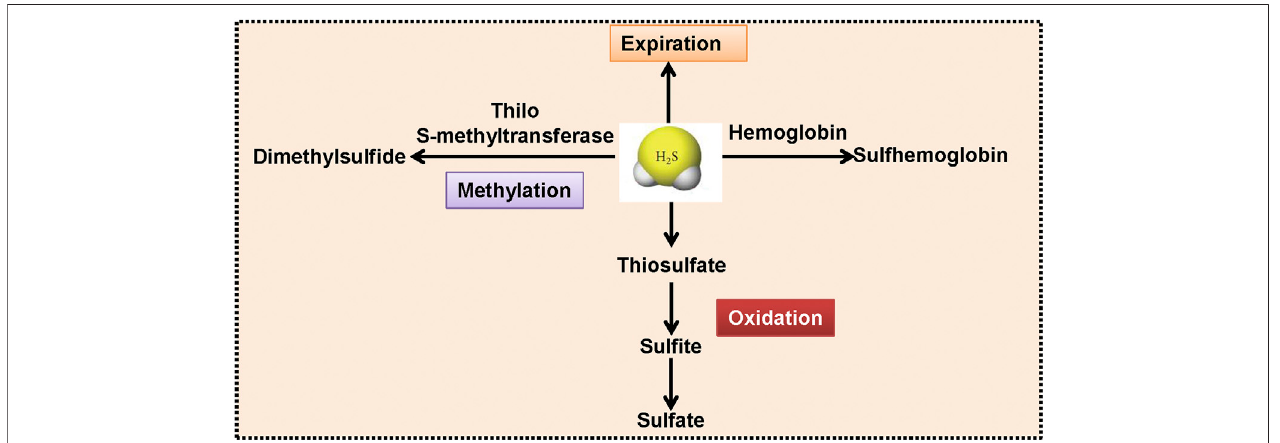
FIGURE 3 | The proposed rotes for H2S degradation. With the aid of thiol S-methyltransferase, H 2 S is methylated into dimethylsul fi de. H 2 S could be oxidized to thiosulfate,coupledwiththeproductionofsul fi teandsulfate.HemoglobininteractswithH 2 S,resultinginthegenerationofsulfhemoglobin.H 2 Scanbereleasedfromthe mammalian lungs. H 2 S, hydrogen sul fi